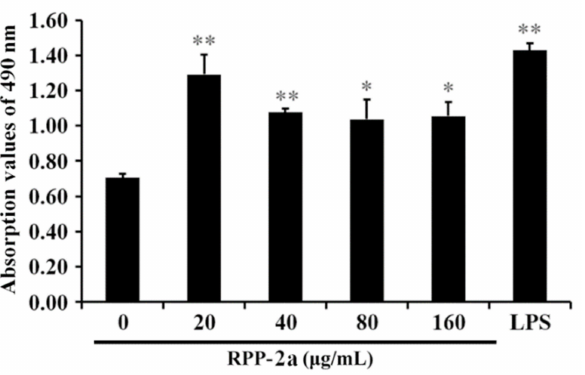
Figure 7. Effect of RPP-2a on the viability of RAW264.7 cells. Data are presented as mean ±